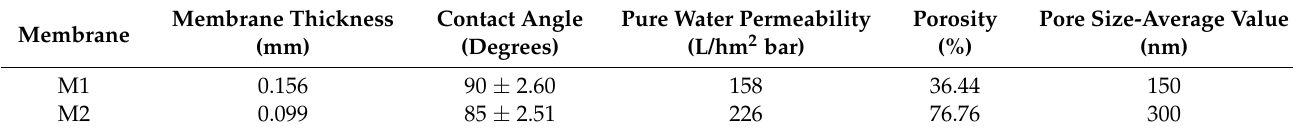
Table 1. Characteristics of the fabricated